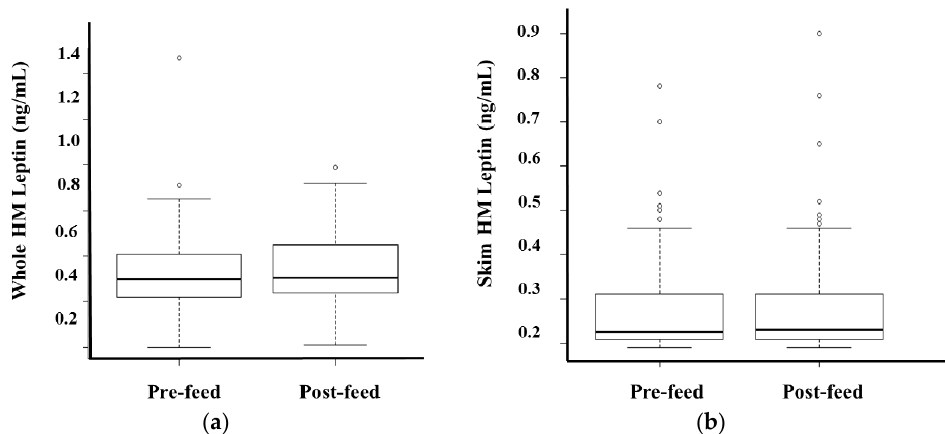
Figure 5. After accounting for the volume of milk consumed by the infant during the session, no differences in pre ‐ and post ‐ feed ( a ) whole and ( b ) skim human milk (HM) leptin values were detected in the study population.